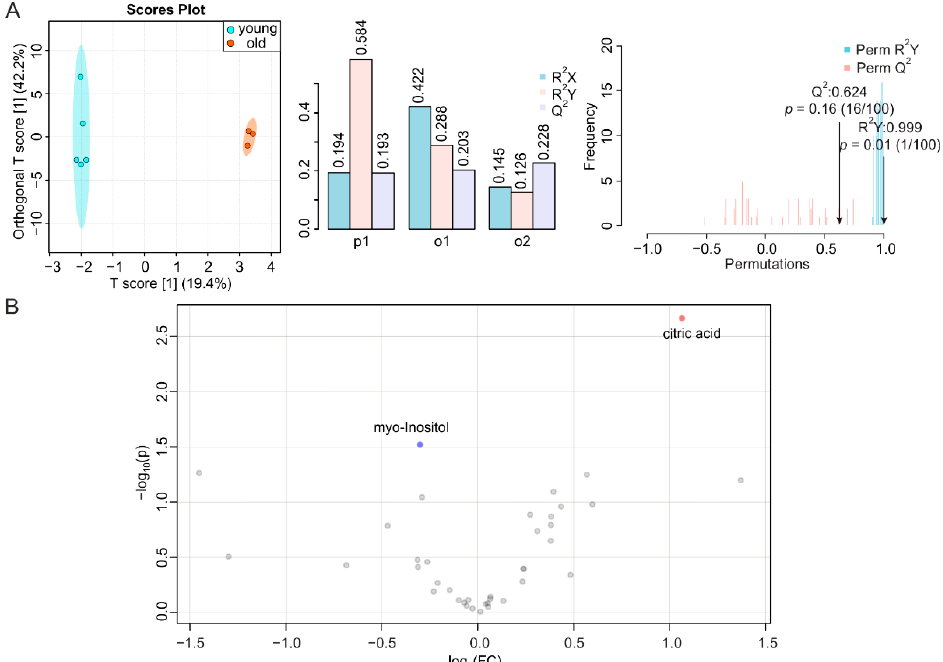
Figure 4. NMR-based metabolomics analysis of WAT. ( A ) O-PLS-DA plot and cross validation of WAT samples from young (blue) and old (orange) mice (left), with n = 5 for young and n = 3 for old, and permutation between predictive component (p1) and two orthogonal components (o1, o2) with cross-validated R 2 X, R 2 Y, and Q 2 coefficients (middle), and histogram showing permutation test with permutation number n = 100 (right). ( B ) Volcano plot of differentially regulated metabolites in WAT from young and aged mice. Increased (red) and decreased (blue) metabolites delimitate the fold change with aging, while grey dots denote insignificantly changed metabolites.